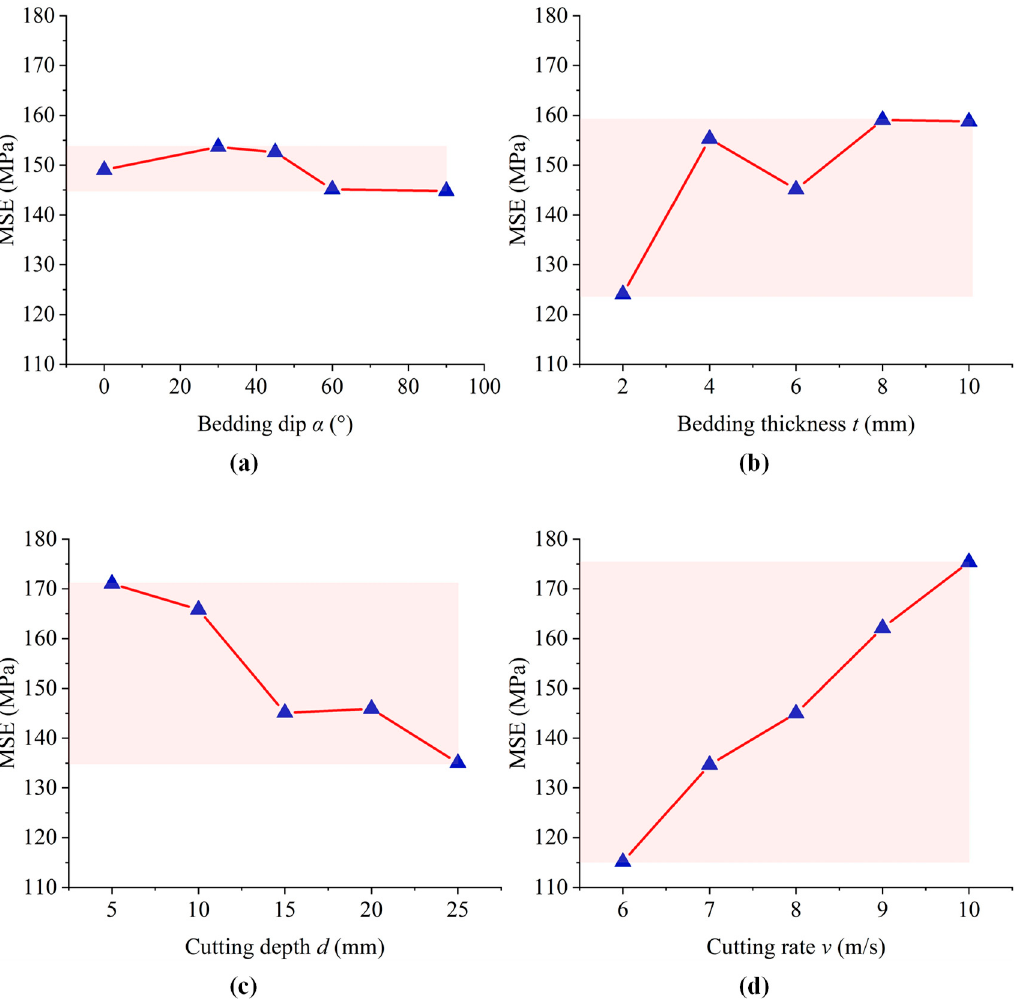
Figure 27. Effect of different factors on mechanical specific energy. ( a ) Effect of bedding dips on mechanical specific energy; ( b ) effect of bedding thicknesses on mechanical specific energy; ( c ) effect of cutting depths on mechanical specific energy; ( d ) effect of cutting rates on mechanical specific energy.